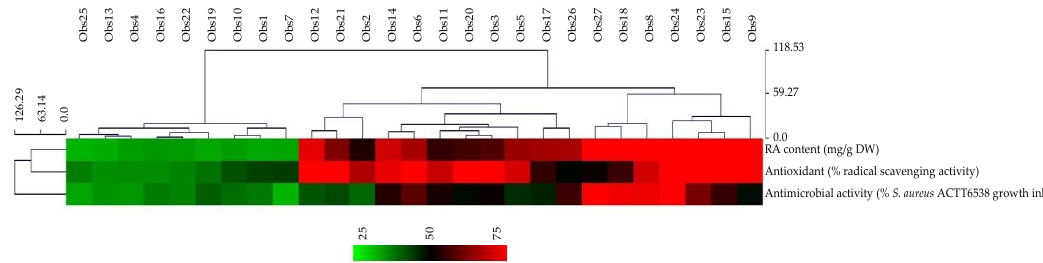
Figure 4. Hierarchical clustering analysis of RA contents and antioxidant (DPPH radical scavenging activity) and antimicrobial (growth inhibition of S. aureus ACTT6538) of the 27 extracts obtained following USAE of P. scutellarioides leaves.